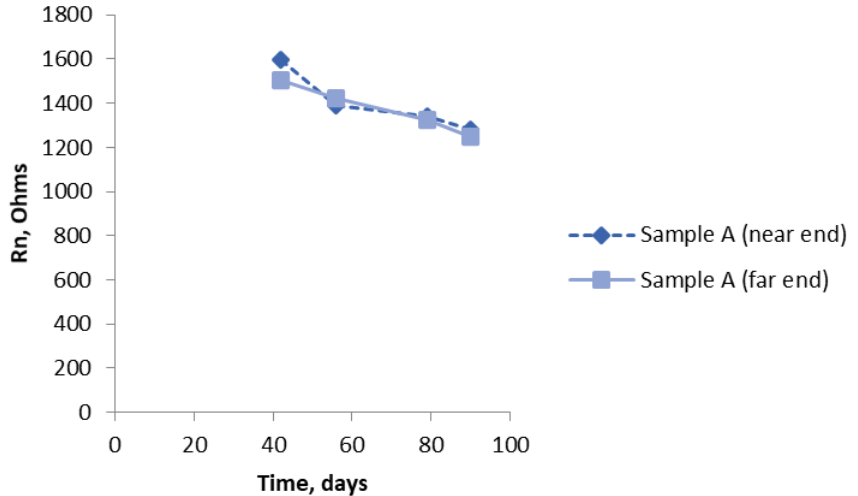
Figure 9. R n results for Sample A (no chloride added) with bridge arrangement measured at both ends.